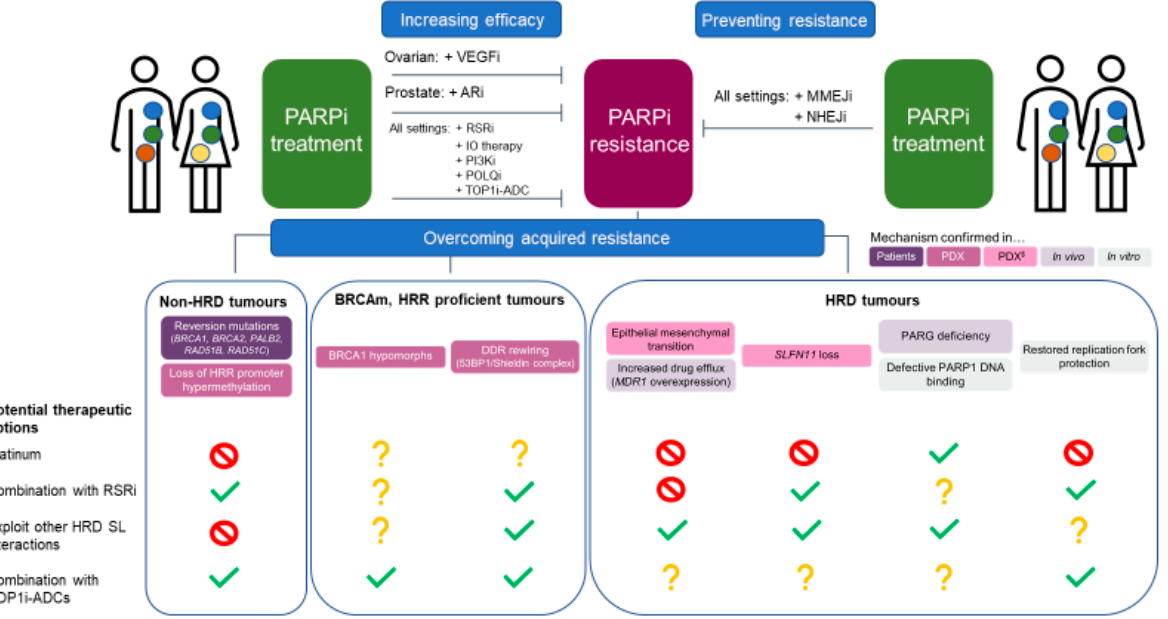
Figure 5. Preventing and tackling PARPi resistance. VEGFi: vascular endothelium growth factor inhibitor; ARi: androgen receptor inhibitor; RSRi: replication stress response inhibitor; IO: immunoncology; ADC: antibody–drug conjugate; PI3Ki: phosphoinositide 3-kinase pathway inhibitor; MMEJi: microhomology-mediated end-joining inhibitor; NHEJi: non-homologous end-joining inhibitor; HRD: homologous recombination deficiency; PDX: patient-derived xenograft; SL: synthetic lethality; HRR: homologous recombination repair.